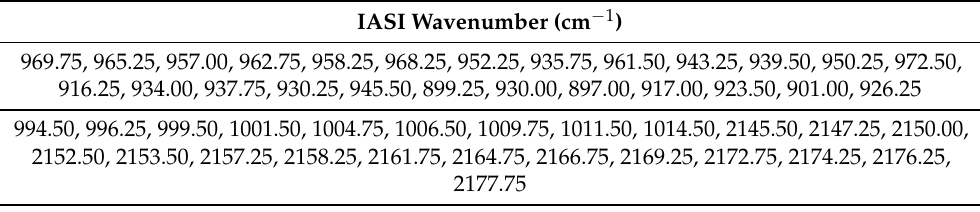
Table A1. List of the 25 IASI wavenumbers sensitive to temperature (upper row) and the 24 IASI wavenumbers sensitive to clouds (lower row) selected for the training of the object detection model YOLOv3.